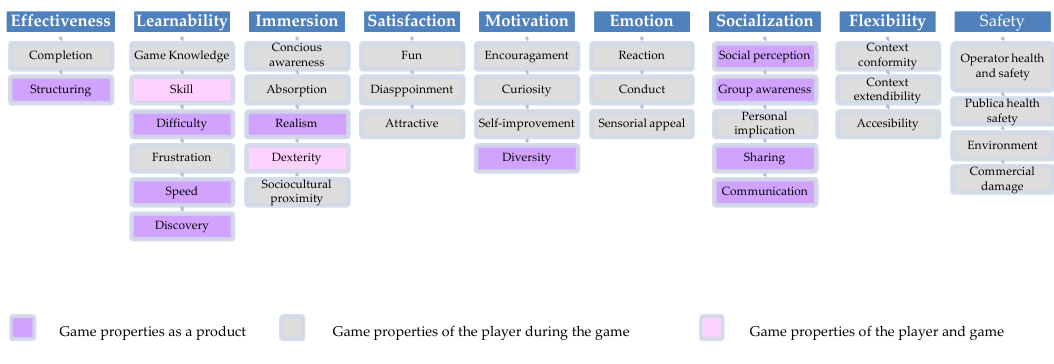
Figure 2. Integrated attributes of games: usability and use.